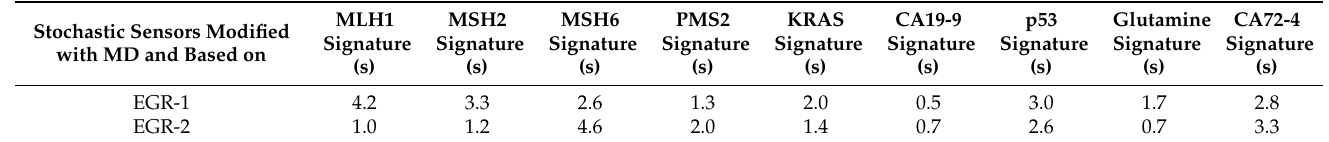
Table 2. Selectivity of the proposed stochastic sensors used for the assay of MLH1, MSH2, MSH6, PMS2 and